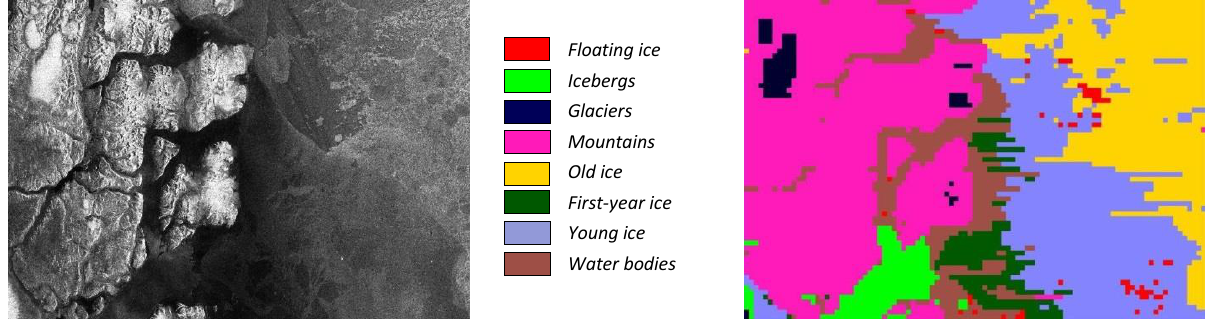
Figure 5.a. Sentinel-1 quick-look view (left) and a classification map (right) for an image of Belgica Bank, Greenland acquired on April 17 th , 2018.